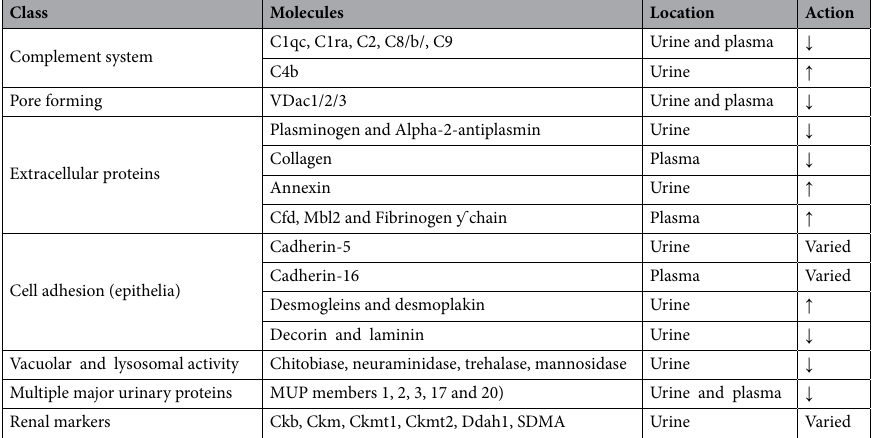
Table 1. Proteomic analyses of D. immitis infected NSG mouse tissues. Summary of proteins significantly altered in NSG mouse plasma and urine.